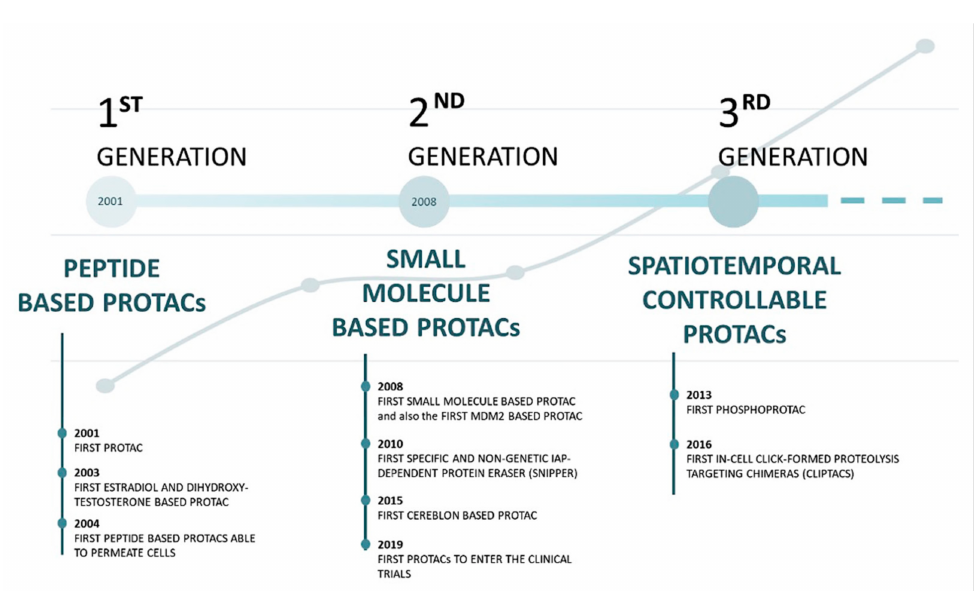
Figure 3. Timeline of the most relevant proteolysis-targeting chimeras (PROTACs) discoveries, and their exponential growth in recent years